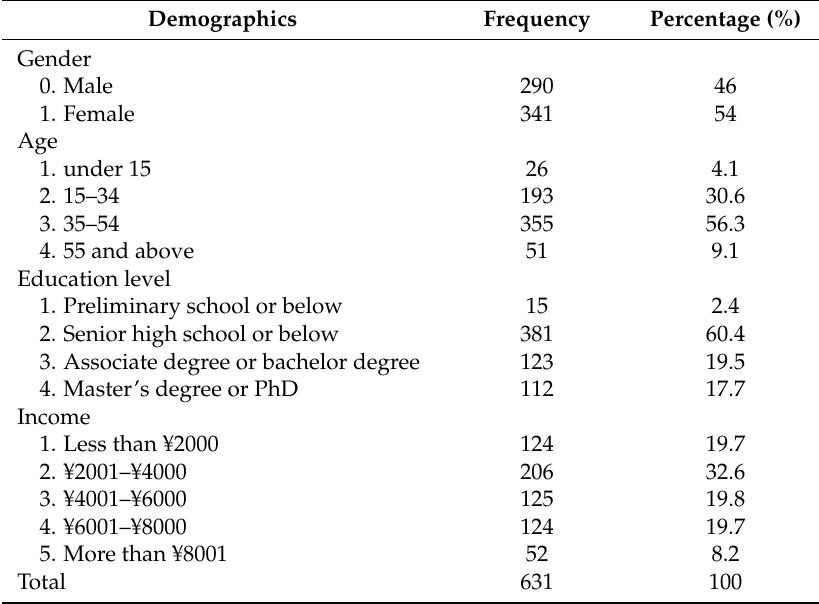
Table 1. Demographic profile of